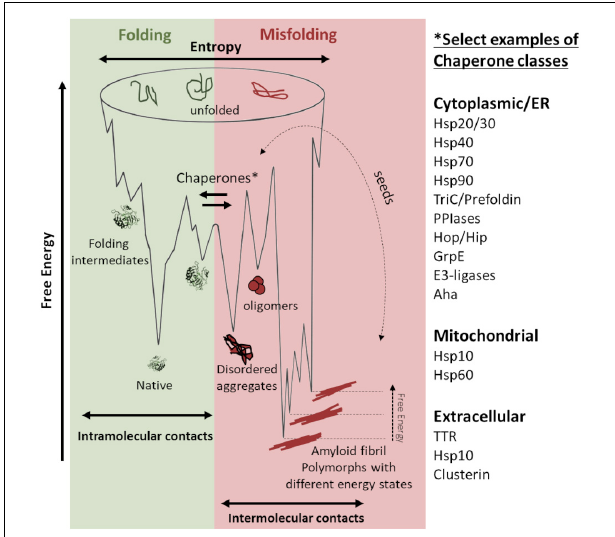
FIGURE 1 | Schematic energy landscapes of protein folding (denoted in green) and misfolding and aggregation (denoted in red). Molecular chaperones keep proteins from misfolding at the intersection between the energy landscapes. There are hundreds of chaperones that facilitate protein folding and shift the landscape toward correct folding (denoted in green). Examples of chaperone classes are listed in the figure. Various amyloid fibril polymorphs have different stable structures, which are kinetically accessible and can propagate by seeded templating (denoted in dotted arrow). Seeding propagates misfolding in an antichaperone mechanism. This results in a tug-of-war between these two sides of the energy landscape: chaperones vs. antichaperones, which results in impaired proteostasis.